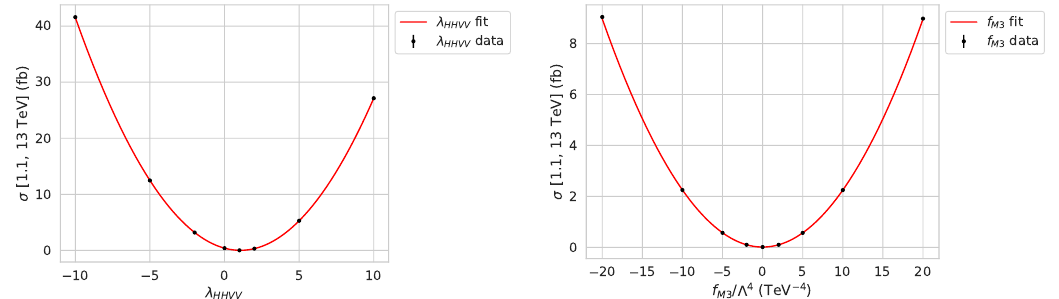
Figure 6 . Quadratic fits of σ [1.1 TeV, 13 TeV] for the VBF-HH process varying κ 2V (left) or f M3